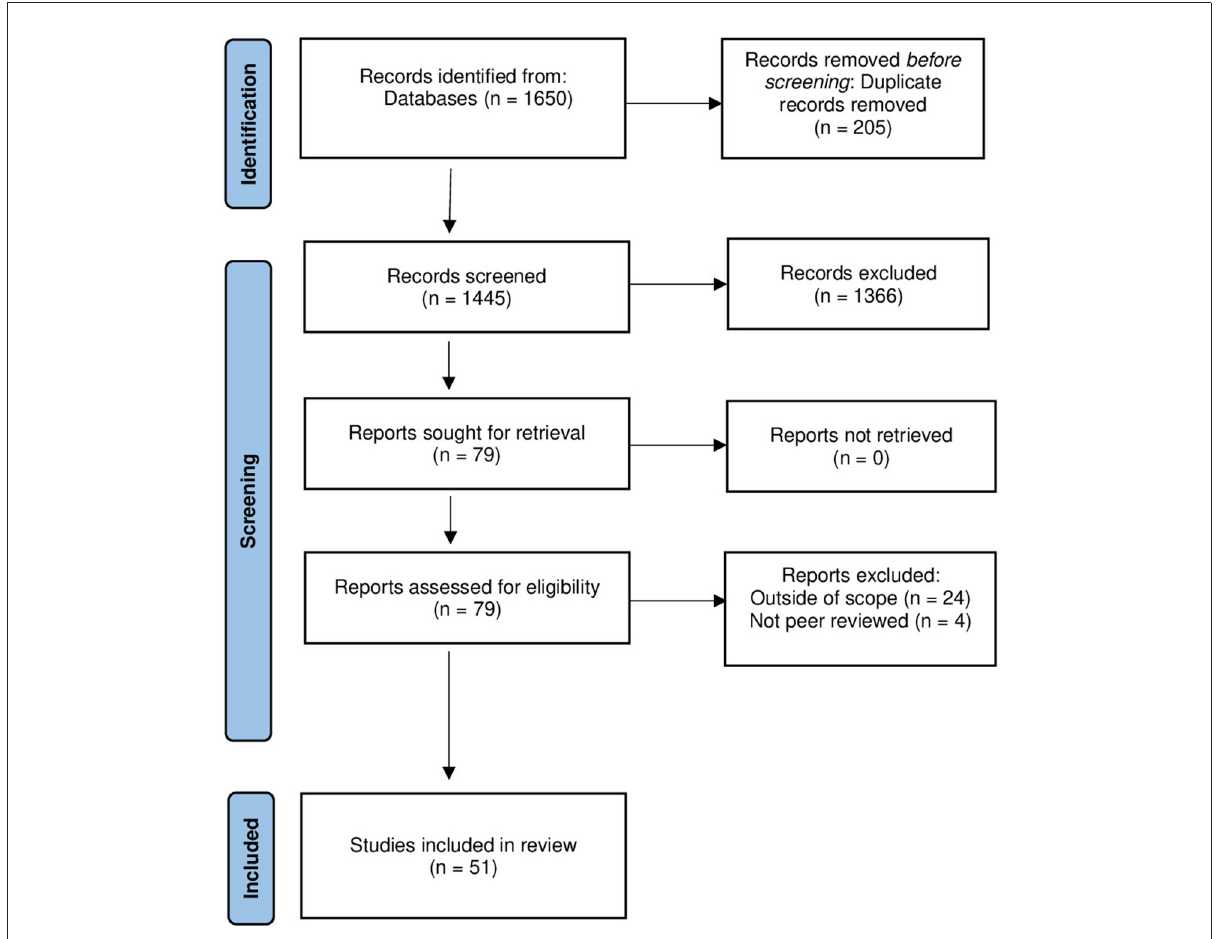
FIGURE1 PRISMA diagram showing the article selection